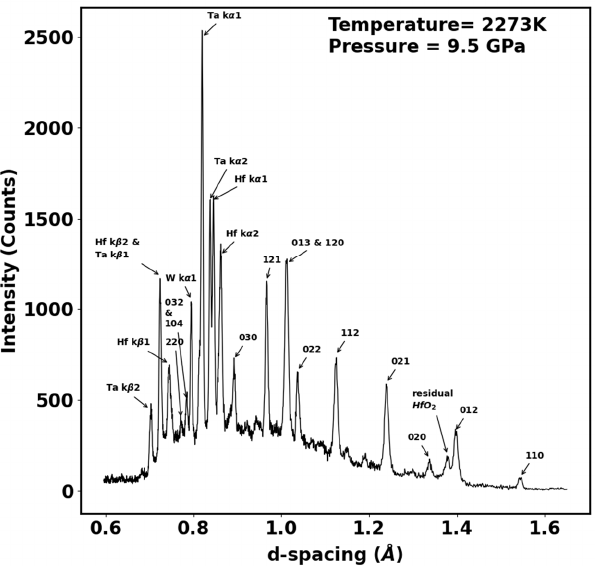
Figure 7. Energy-dispersive X-ray diffraction spectrum of the (Hf, Mo, Nb, Ta, Ti)B 2 sample at a pressure of 9.5 GPa and temperature of 2273 K. The sample peaks are indexed to a hexagonal AlB 2 phase, with lattice parameters described in the text, along with the fluorescence peaks from the constituent elements. A weak peak from residual precursor material hafnium dioxide is also indicated.